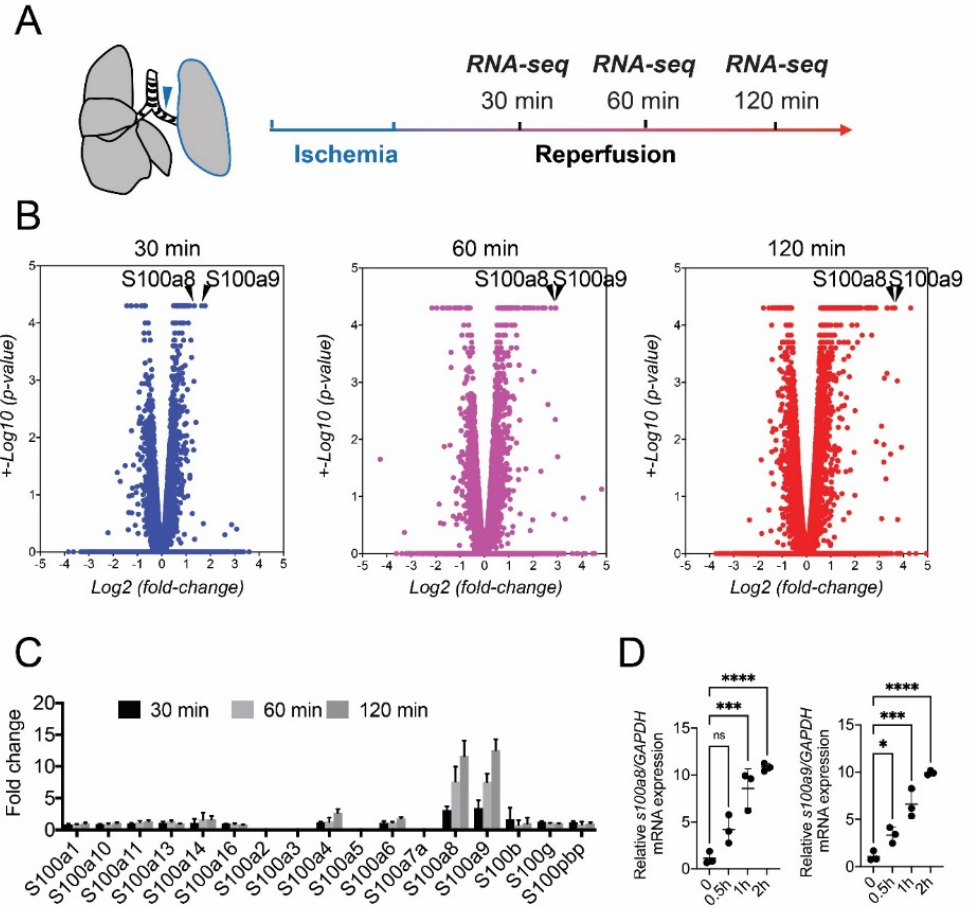
Figure 1. Experimental strategy for RNA sequencing. ( A ) After ischemia for 30 min, reperfusion was conducted for 30, 60, and 120 min, followed by RNA sequencing ( n = 3). ( B ) Volcano plots of transcriptome data of whole lung tissue of ischemia-reperfusion (IR) mice (30 (blue), 60 (purple), and 120 min (red)). S100A8 and S100A9 are shown as a8 and a9, respectively. ( C ) Expression levels of S100 family genes in IR mice (IR-30, IR-60, and IR-120 min). All data were extracted from RNA sequencing data (fragments per kilobase of exon per million fragments mapped reads). ( D ) Black balls stand for relative expression levels of mRNAs encoding S100A8 and S100A9 by quantitative real-time reverse-transcription polymerase chain reaction (qRT-PCR) ( n = 3). Data are expressed as means ± standard deviation (SD), * p < 0.05, *** p < 0.001, **** p <